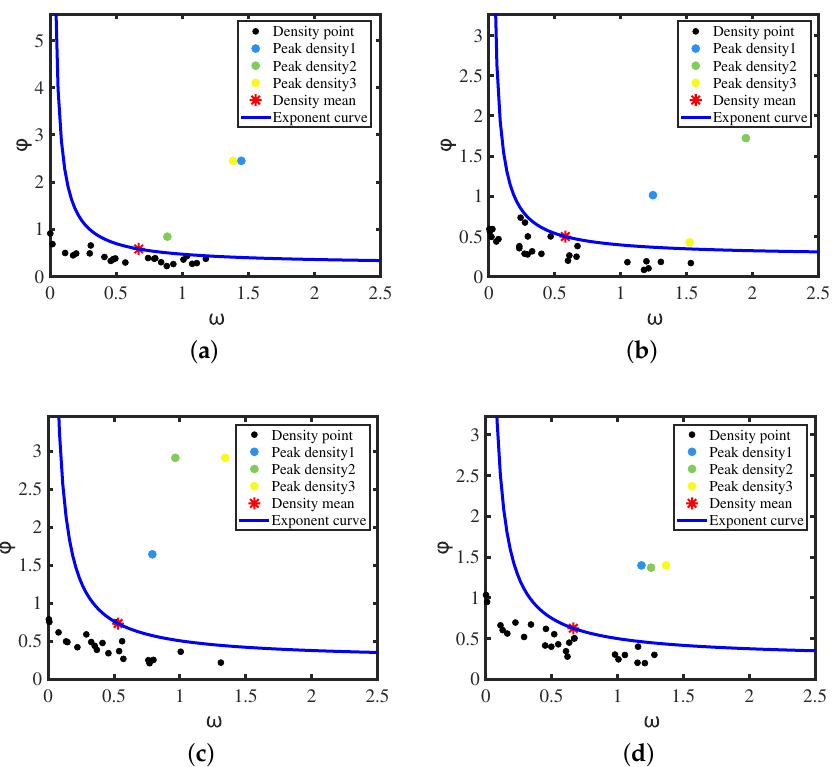
Figure 8. The decision chart corresponding to the radar detection data Dataset 1 to Dataset 4: ( a ) Decision graph of Dataset1; ( b ) Decision graph of Dataset2; ( c ) Decision graph of Dataset3; ( d ) Decision graph of